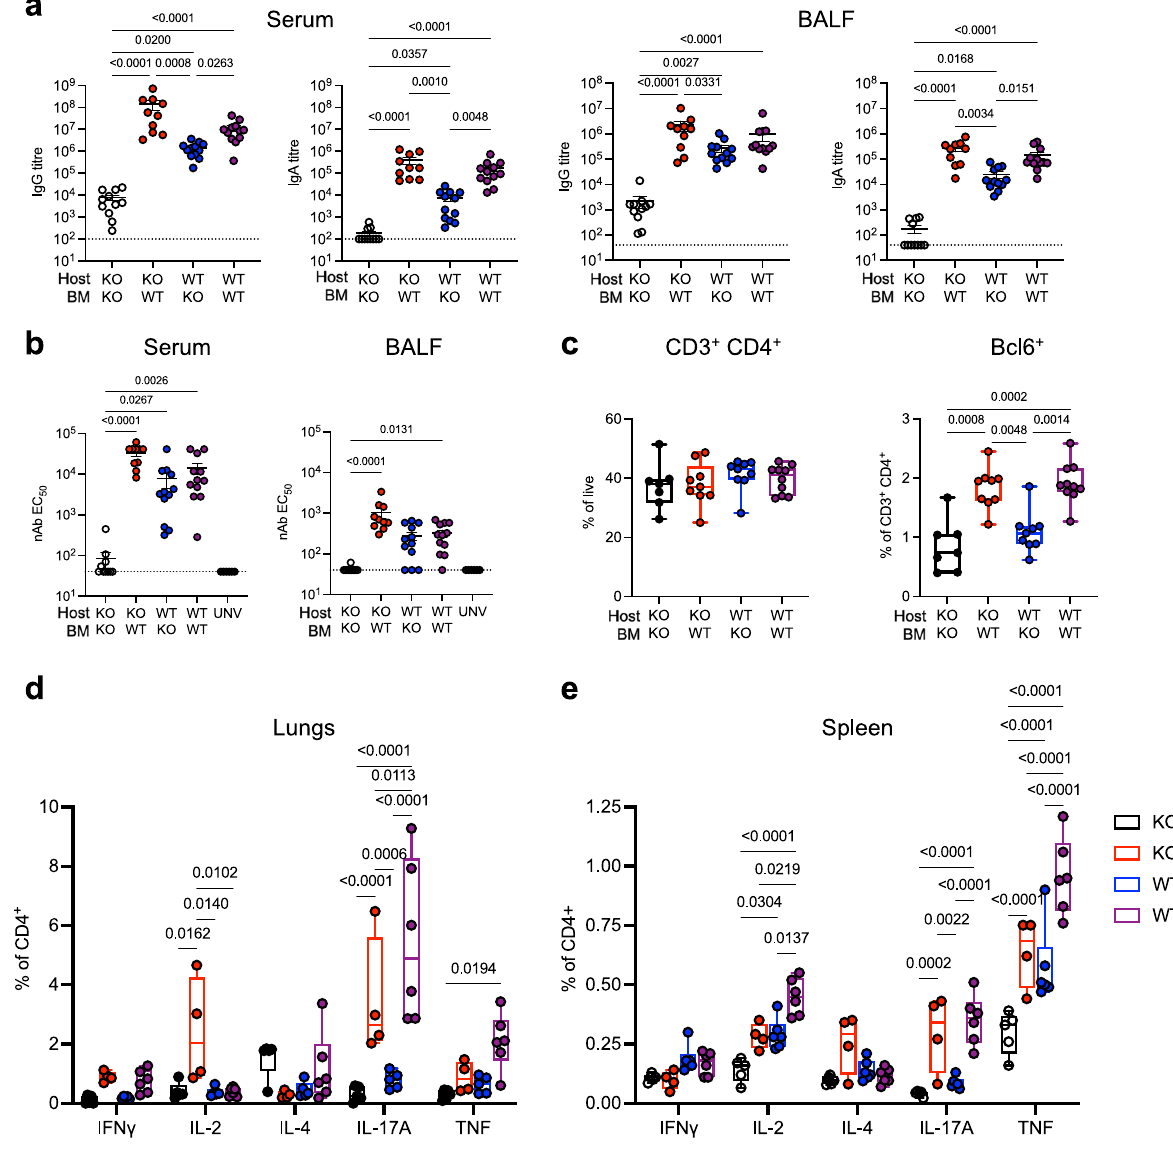
Fig. 7 | TLR2 expression by the hematopoietic lineage is required for optimal Spike-speci fi c antibody and CD4+ T-cell responses in the lung following mucosal vaccination and boosting with Pam2Cys Spike. Tlr2 − / − (KO) or wild type (WT) mice were lethally irradiated then received transfer of Tlr2 − / − or WT bone marrow (BM) cells i.v. Mice were rested for 12 weeks to allow hematopoietic reconstitution and replacement, then immunized with Pam 2 Cys Spike i.n three times, two weeks apart. Immune responses were characterized at one week post fi nal vaccination. Control mice were unvaccinated Tlr2 − / − (UNV). a Anti-spike IgG and IgA titres (log 10 scale) in serum and bronchoalveolar lavage fl uid (BALF) determinedbyELISA. b Neutralizingantibody(nAb)titres(log 10 scale)inserumand BALF of vaccinated mice weredetermined asthe titreneeded for50%inhibition of SARS-CoV-2 Spike-expressing lentivirus in HEK293-ACE2 cells. Limits of detection